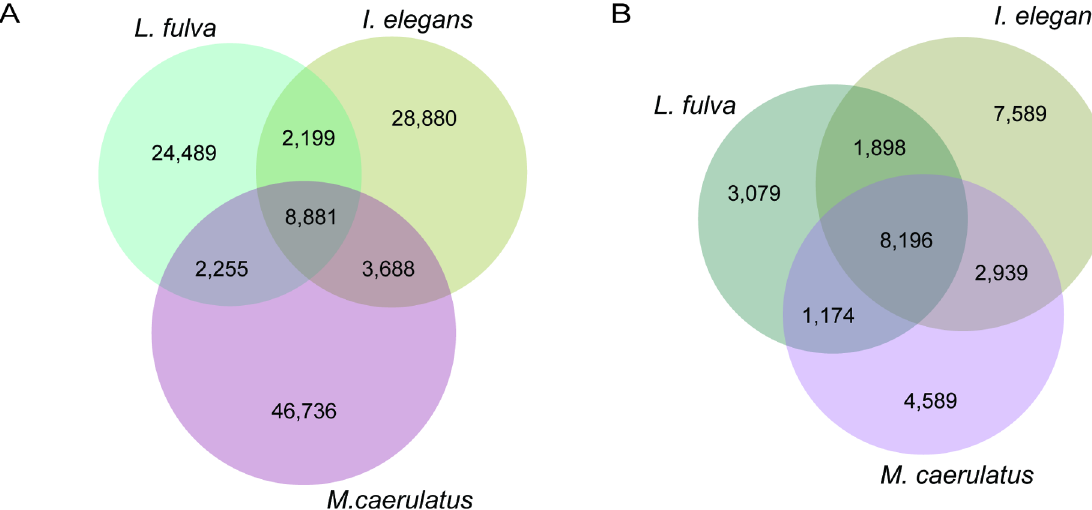
Fig 3. Comparisons among three odonate transcriptomes based on the open reading frames: Ladona fulva , Ischnura elegans , and M . caerulatus . A) The overallsequencesimilarity identifiedvia reciprocal blast search among transcriptomes presented in a Venn diagram shows a greater numberof overlappinggenesbetween M . caerulatus and I . elegans than between the dragonfly L . fulva and the two damselflies. B) Overlapping orthologousgene clusters (OrthoVenn). Both analysesshow a similar sized overlapamong